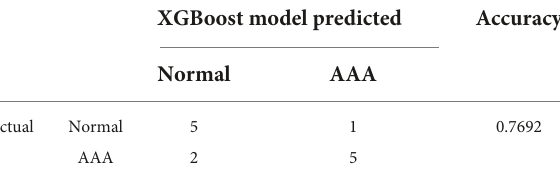
TABLE 2 The predictive ability of XGBoost model in